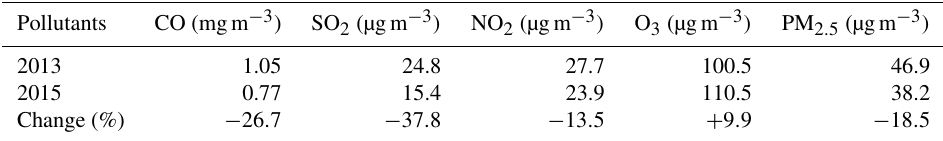
Table 2. Observed hourly mass concentrations of pollutants averaged in the afternoon from April to September 2013 and 2015 in 65 cities of eastern